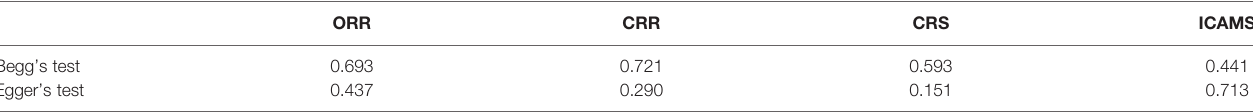
TABLE 4 | Begg ’ s and Egger ’ s tests of ORR, CRR, CRS and ICANS in all included